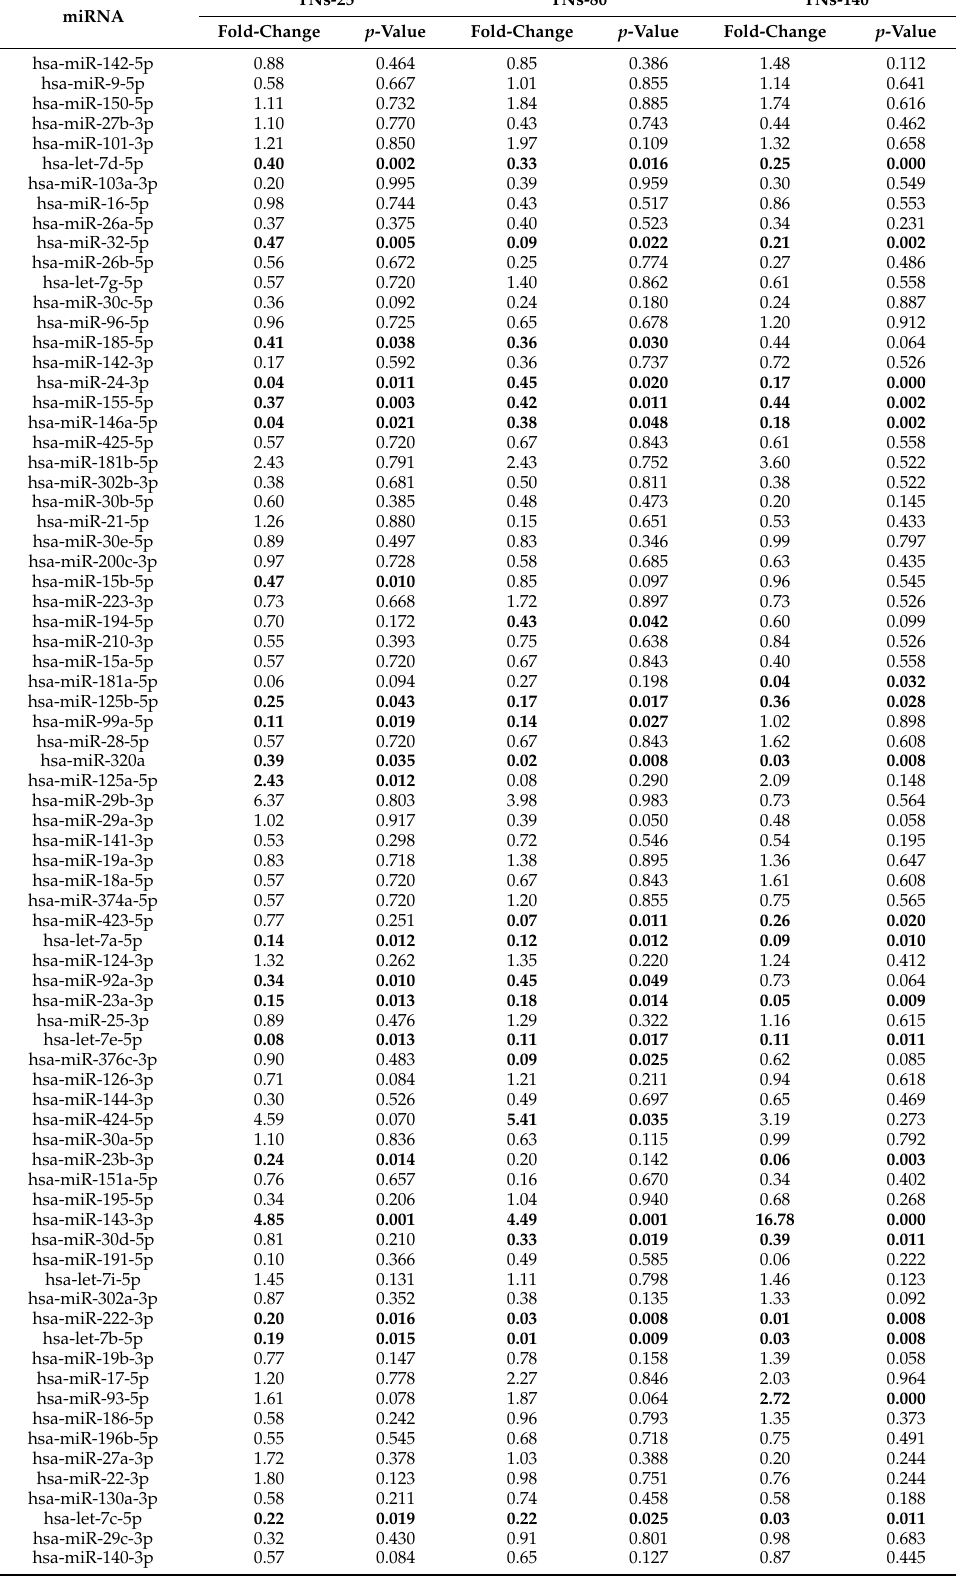
Table 4. Fold change expression levels and relative p -values of miRNAs in exosomes isolated from hMSCs grown on the TNs-25, TNs-80, and TNs-140 surfaces for 7 days versus exo-hMSCs from T-untreated surfaces.